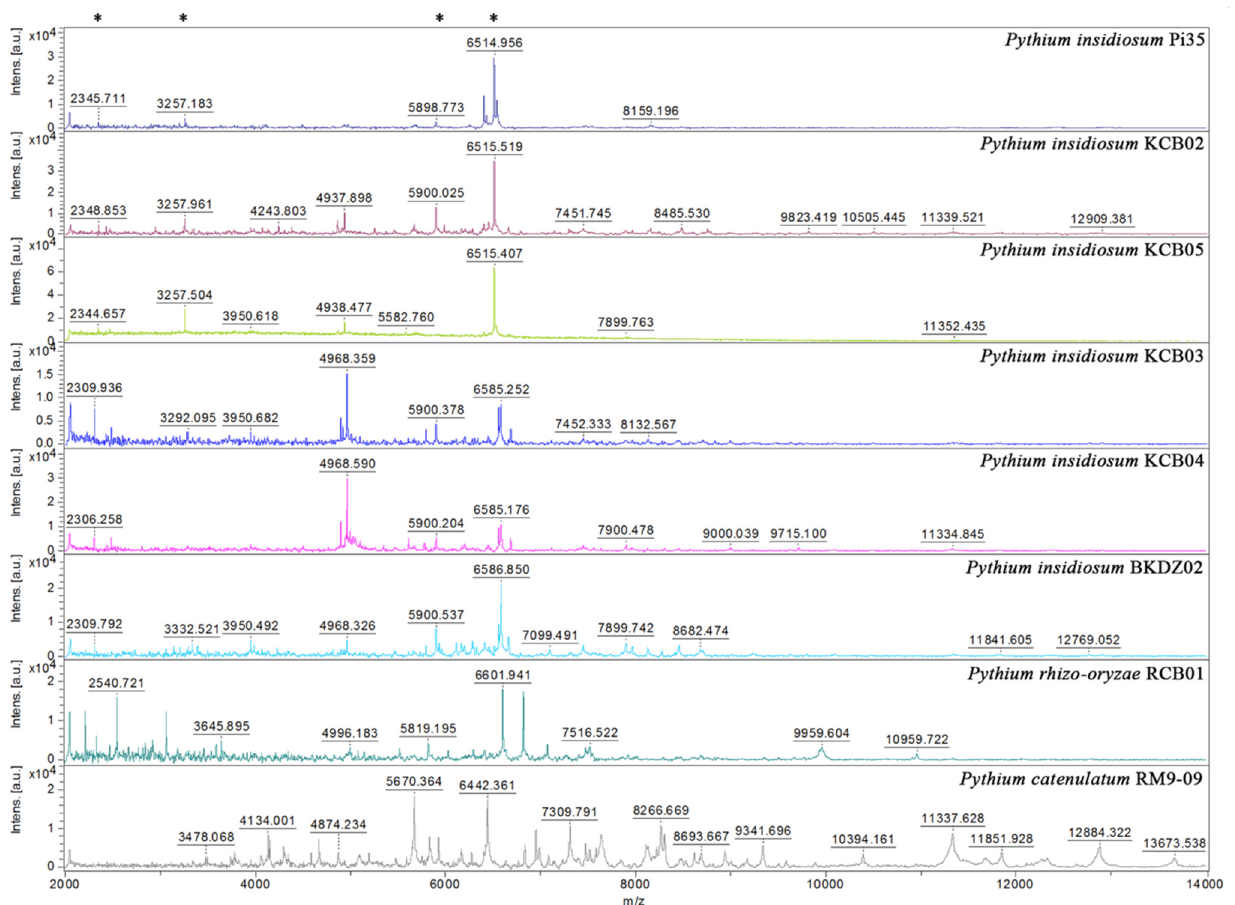
Figure 4. Comparison of mass spectra from P. insidiosum and non- insidiosum Pythium species. Four mass spectra are generated from P. insidiosum strains inhabited in the same rice field (IDs: KCB02, KCB03, KCB04, and KCB05). One each of the mass spectra is derived from P. insidiosum strain BKDZ02 (from a zoo in Bangkok), P. rhizo-oryzae strain RCB01 (from a pond in Ratchaburi province), and P. catenulatum strain RM9-09 (from a pond in Bangkok). The P. insidiosum strain Pi35 (from a pythiosis patient) is included as a reference organism. The Y -axis shows mass intensity, while the X -axis represents the mass-to-charge ratio (m/z). Asterisks indicate the prominent m/z peaks that share among different strains of P. insidiosum.